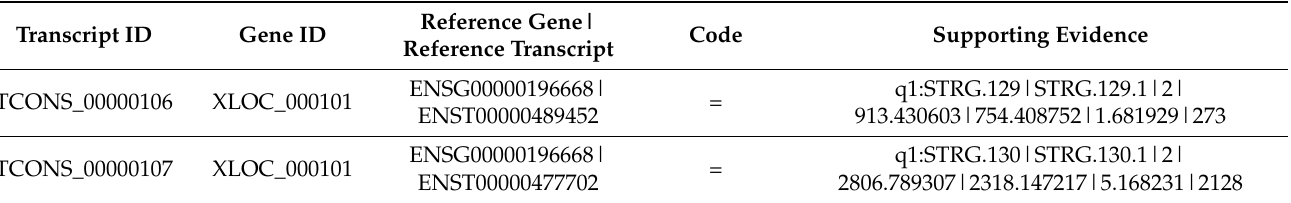
Table 2. Output of GffCompare for the use case, comparing the results of StringTie to the Ensembl reference